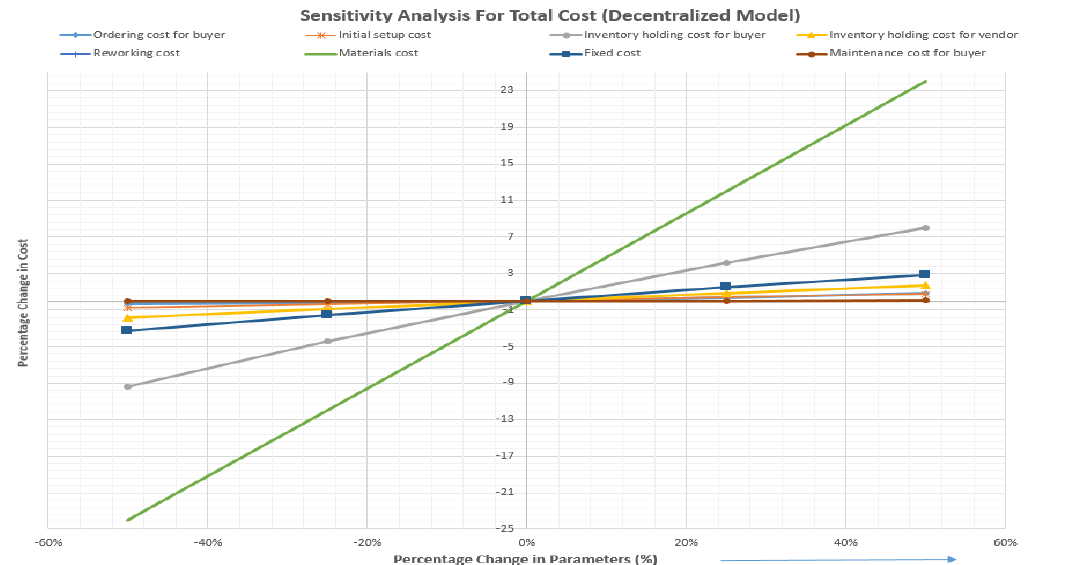
Figure 2. Sensitivity analysis: total cost versus change in parameters under decentralized model.